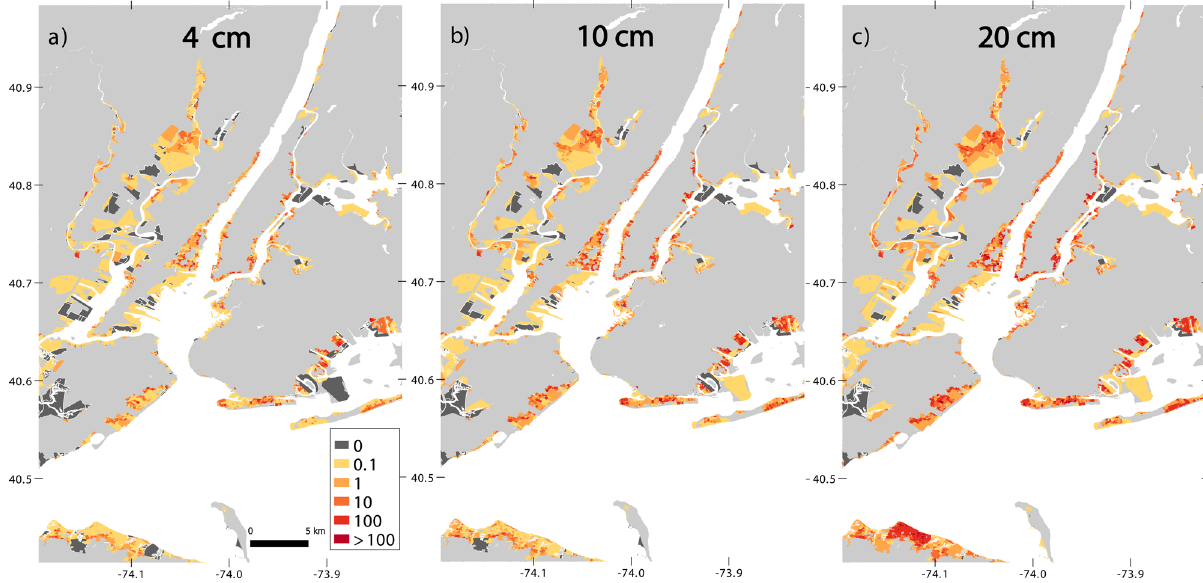
Fig. 2 Differences in Census block-level modeled damages ($Million) between actual sea level and each of three counterfactual ones, for Manhattan and surrounding areas. a 4 cm subceeds the 5th percentile value of all but one anthropogenic sea-level-rise estimate (see Table 1); b 10 cm roughly matches the total ensemble median; and c 20 cm exceeds the largest 95th percentile value. Legend values represent bin upper limits. For visibility, full blocks are shaded even when only a fraction of the block fl